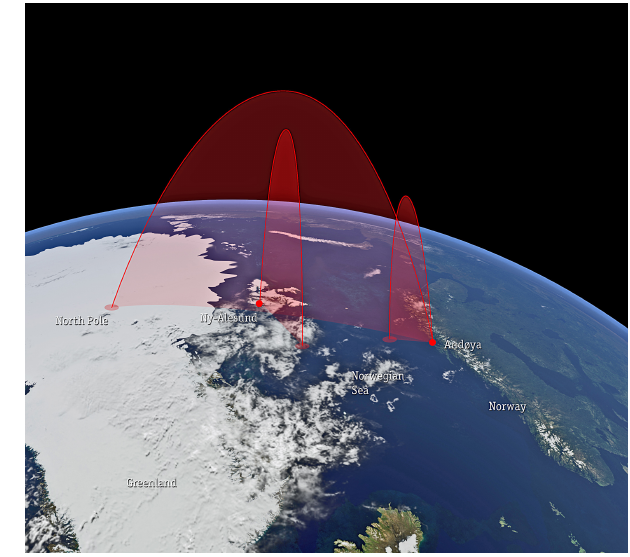
Figure 7. Types of rocket trajectories.